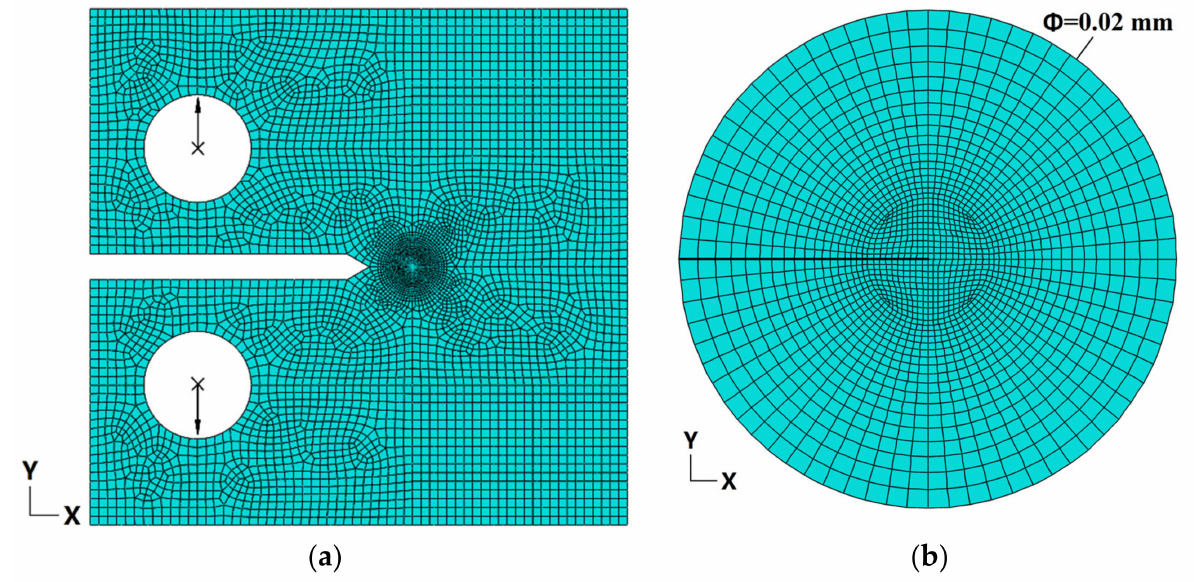
Figure 2. Finite element model of CT specimen. ( a ) The whole model and ( b ) meshes around the crack tip.